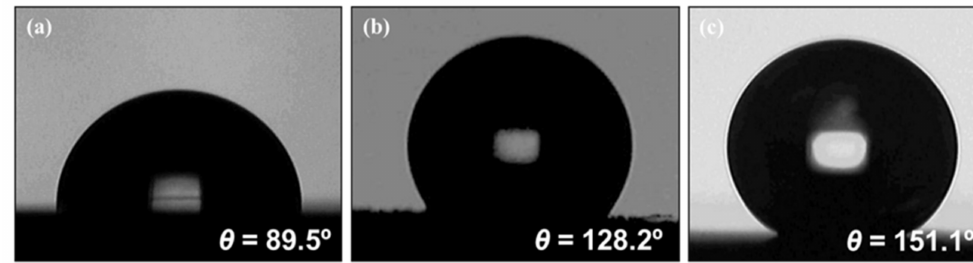
Figure 3. Surface wettability of ( a ) bare stainless steel, ( b ) stainless steel electrochemically etched at 10 V for 10 min, and ( c ) stainless steel electrochemically etched at 10 V for 10 min with Teflon coating.